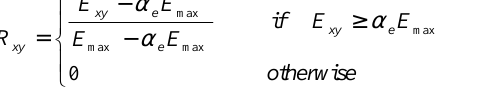
Figure 4. Example of OC image